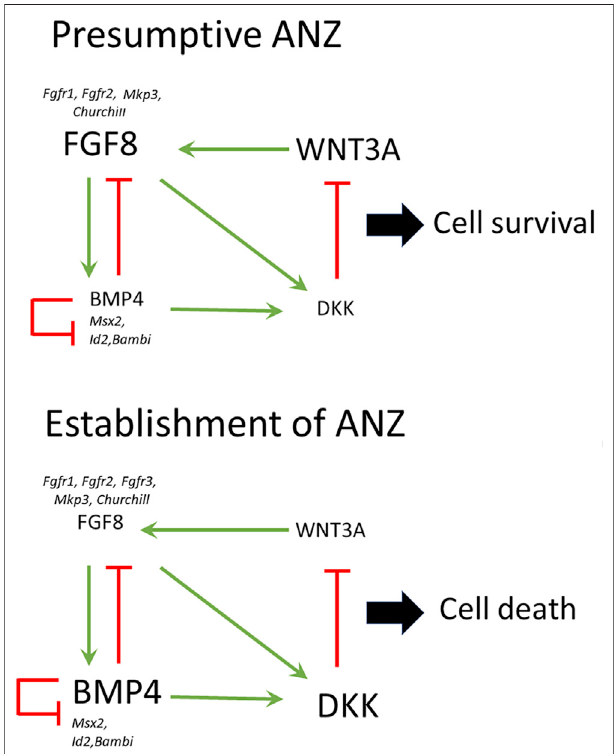
FIGURE 8 | Establishment of the ANZ by the WNT-BMP-FGF regulatory network. In this model, WNT3A and BMP signaling antagonistically regulate Fgf8 expression and consequentlycell death. WNT3A induces the expression of Fgf8 in the AER. BMP signaling inhibited Fgf8 expression; meanwhile, DKK inhibits the function of WNT/ß catenin signaling, and consequently, the expressionof Fgf8 isinhibited.InthepresumptiveANZ,thehighlevelsofFGF8 from AER are necessary for cell survival, but FGF8 is also required for promotingcelldeathregulating Bmp4 and Dkk expression.Theestablishment of ANZ occurs when the levels of FGF signaling are reduced and BMP signaling increases leading to the inhibition of Fgf8 in the AER inducing cell death. Fgfr1, Fgfr2, Mkp3, Churchill, Msx2, Id2, and Bambi are expressed differentially in the presumptive ANZ and the established ANZ.